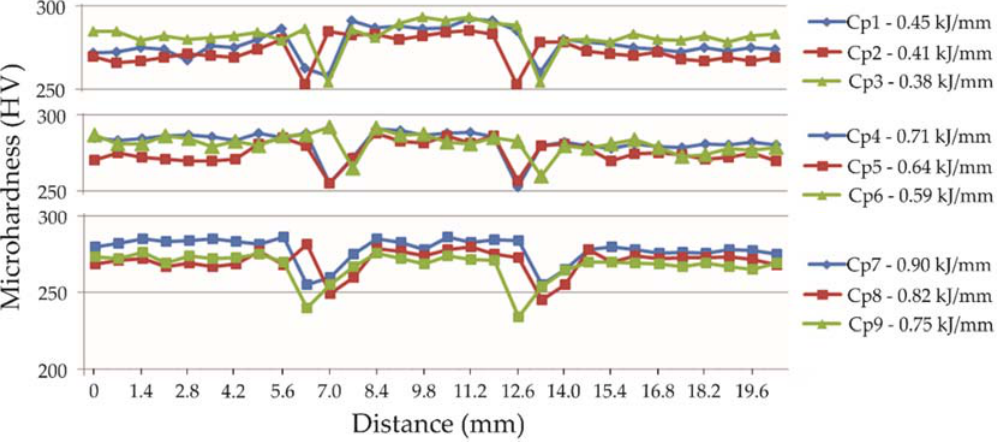
Figure 4. Microhardness profile for different welding powers.